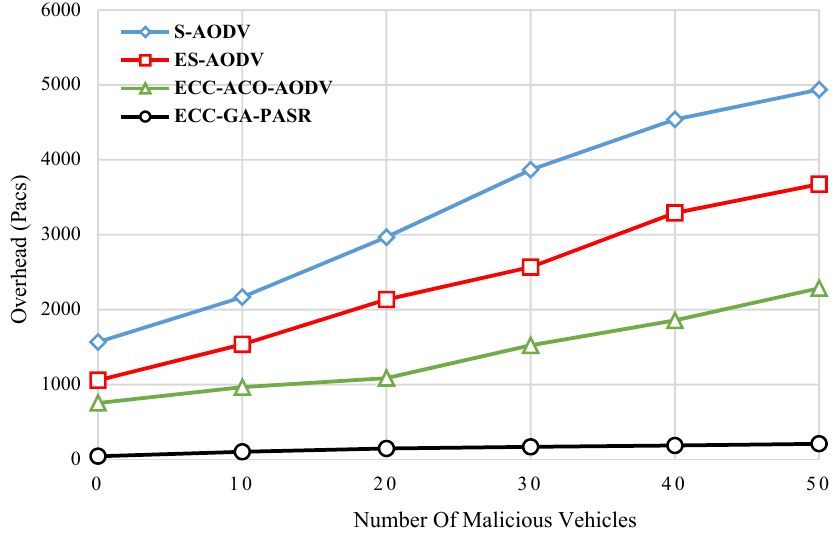
Figure 19. Overhead Calculation based on number of malicious vehicles.